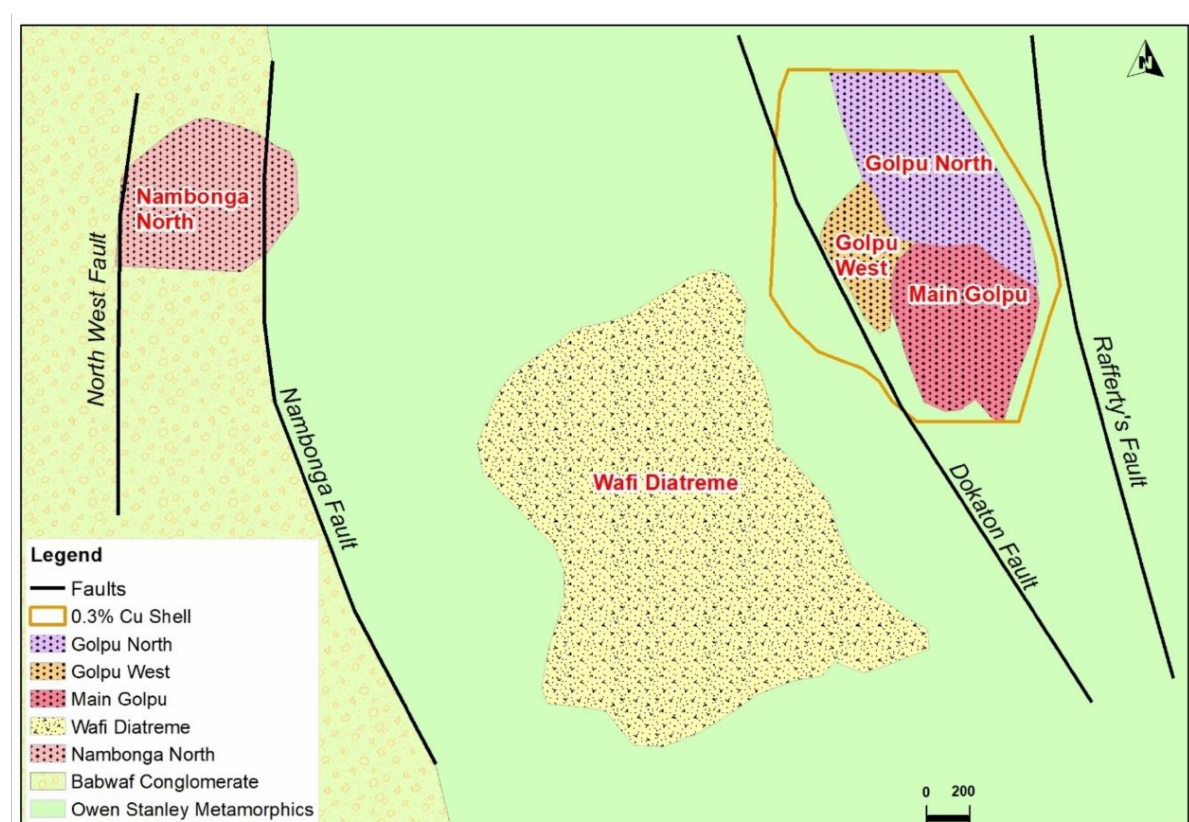
Figure 3. Plan view showing the Golpu porphyries, Nambonga North porphyry and Wafi Diatreme in the WGMD. Other intrusive suites have not been